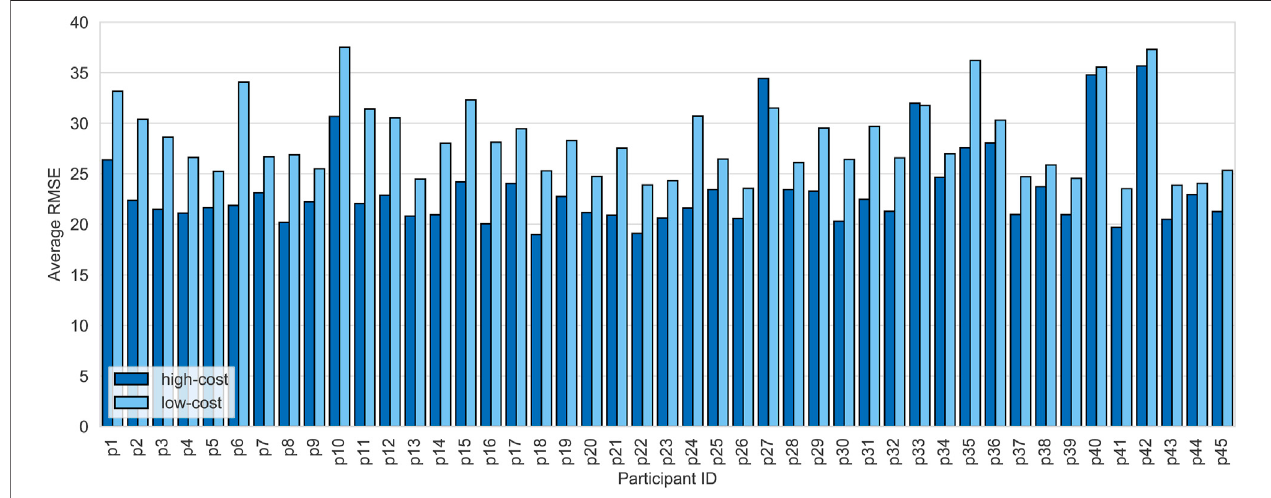
FIGURE7| Reprojectionerrorsforthehigh-and low-costself-avatarsofeveryparticipant(p1 – p45).Thereprojectionerrorswerecalculatedbyaveragingtheroot- mean-square error (RMSE) over all input images.